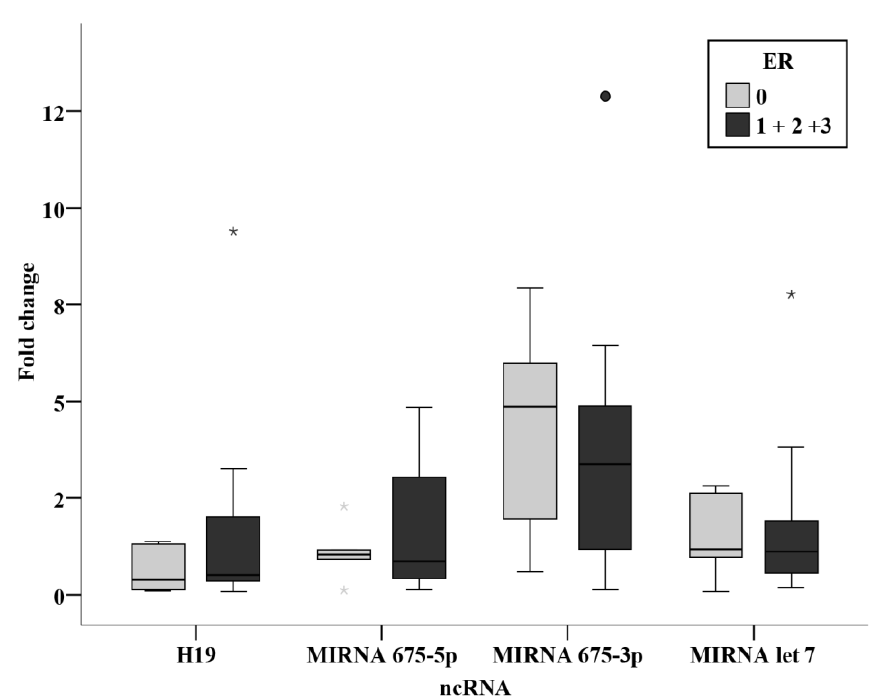
Figure 12. Relation between ncRNAs and ER status in the prechemotherapy BC patients. *- Extreme value.